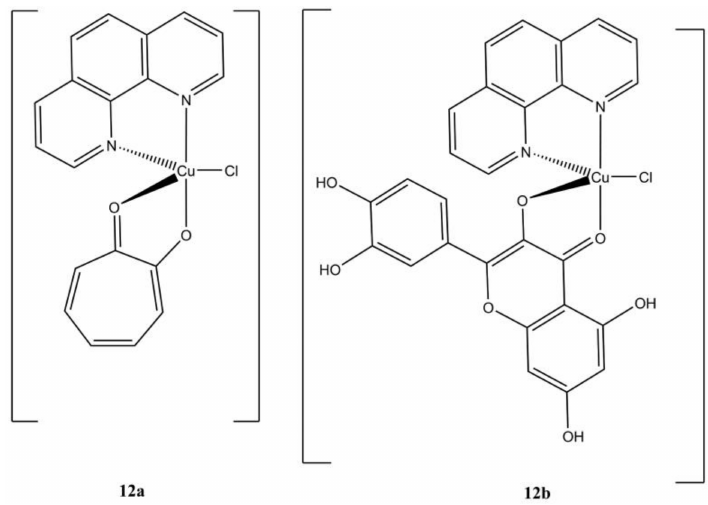
Figure 12. Structures of complexes [Cu(phen)(trop)(Cl)] ( a ) and [Cu(phen)(H 4 Que)(Cl)] ( b ). Table 4. IC 50 values of compounds 6a – 12b .